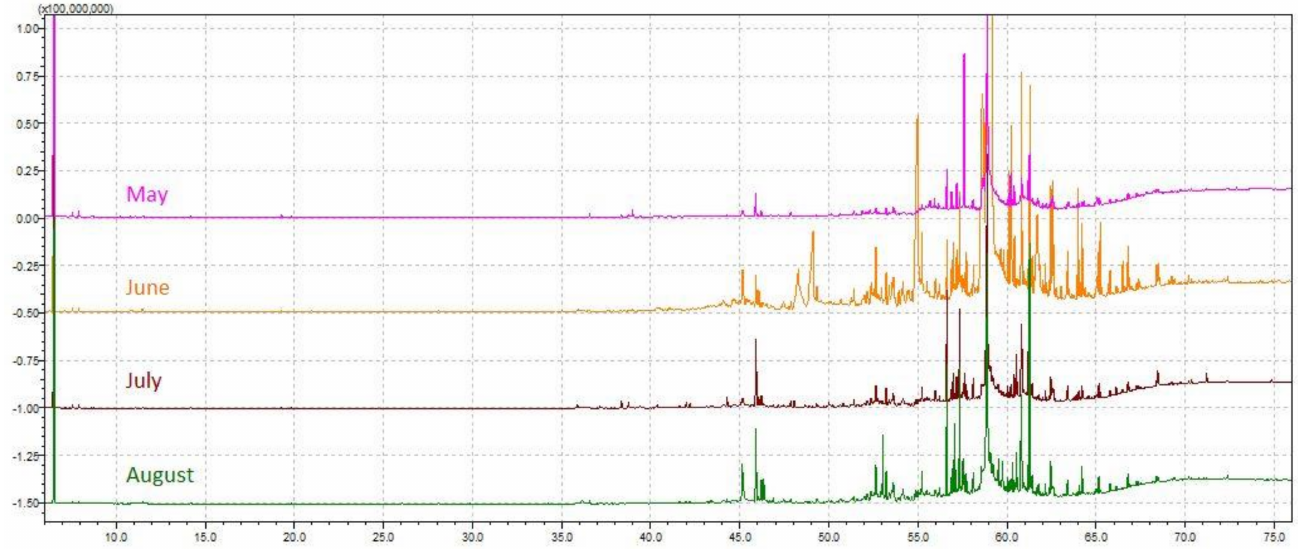
Figure 2. GC–MS chromatograms of the essential oils obtained from Cystoseira compressa collected from May to